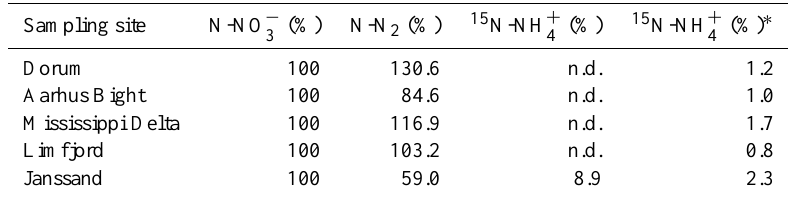
(indicating DNRA activity) were calculated as 4 production; n.d.: not detected. 4